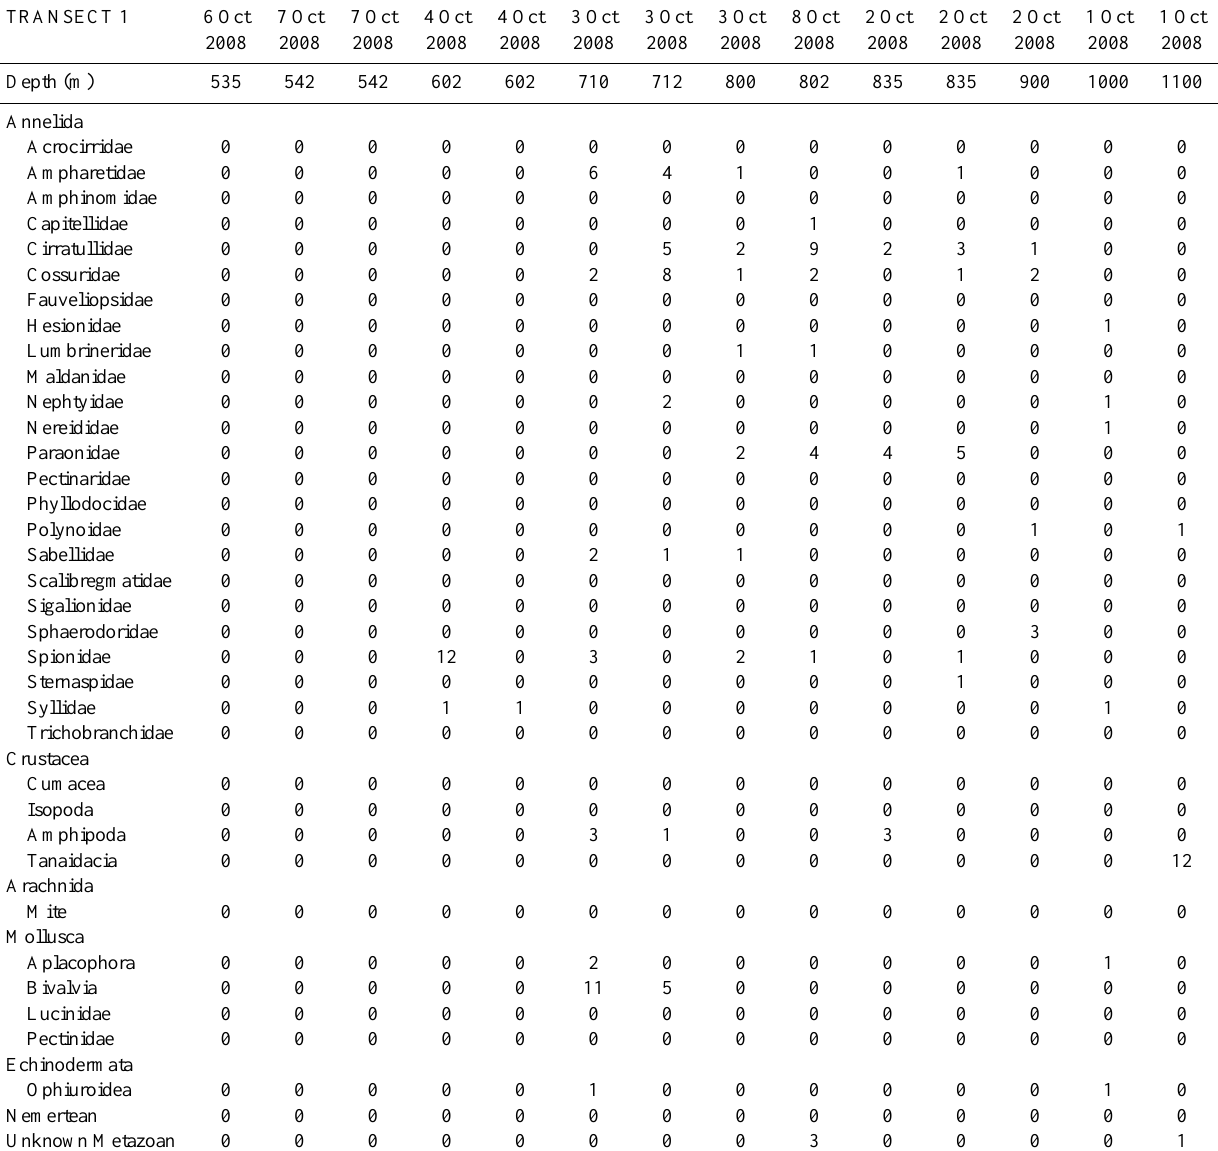
Table 3a. Background macrofaunal densities (no. per 8.3cm diameter core), transect 1 (see Table 1 for locations). TRANSECT 1